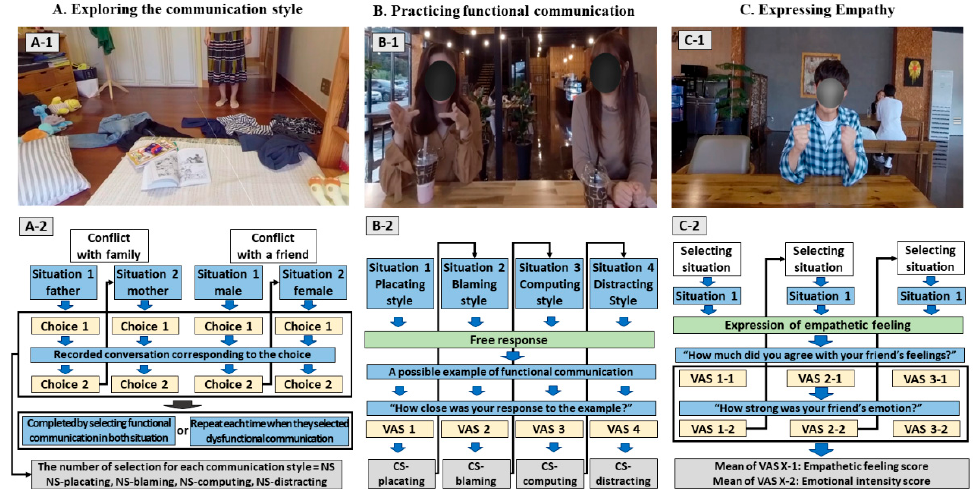
Figure 1. Screenshots and schematic diagrams of enhancing functional communication. Although the tasks were conducted in Korean, the procedure here is explained in English for the convenience of understanding. To protect the portrait rights of the cast, the faces are obscured. Abbreviation: VAS, visual analog scale; NS, the number of selections; CS, communication score .